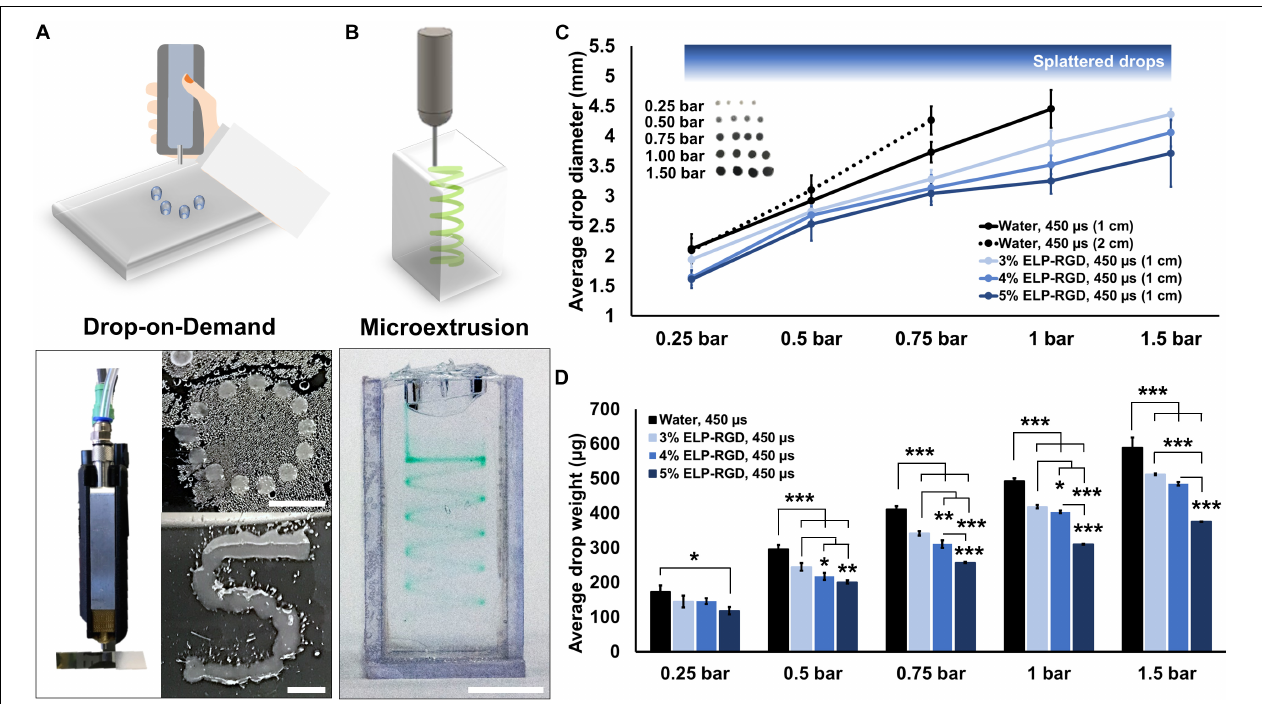
FIGURE 3 | Printability of ELP-RGD bioinks. (A) Qualitative drop-on-demand (DoD) printability tests of 3 wt% ELP-RGD printed as single drops into circular and S shapes. Scale bars represent 5 mm. (B) Qualitative microextrusion printability test of 3 wt% ELP-RGD in a spiral shape within a Pluronic bath. Scale bar represents 5 mm. (C) Average single drop diameter of deionized water, 3, 4, and 5 wt% ELP-RGD printed by DoD at applied pressures ranging from 0.25 to 1.5 bar ( n = 10). (D) Average single drop mass of deionized water, 3, 4, and 5 wt% ELP-RGD printed by DoD at applied pressures ranging from 0.25 to 1.5 bar ( n = 3, 100 drops each). Valve opening time (gating time) was fixed at 450 µ s for all experiments. Statistical significance marked as * p < 0.05, ** p < 0.005, and *** p < 0.001 (One-way ANOVA with Tukey’s post hoc